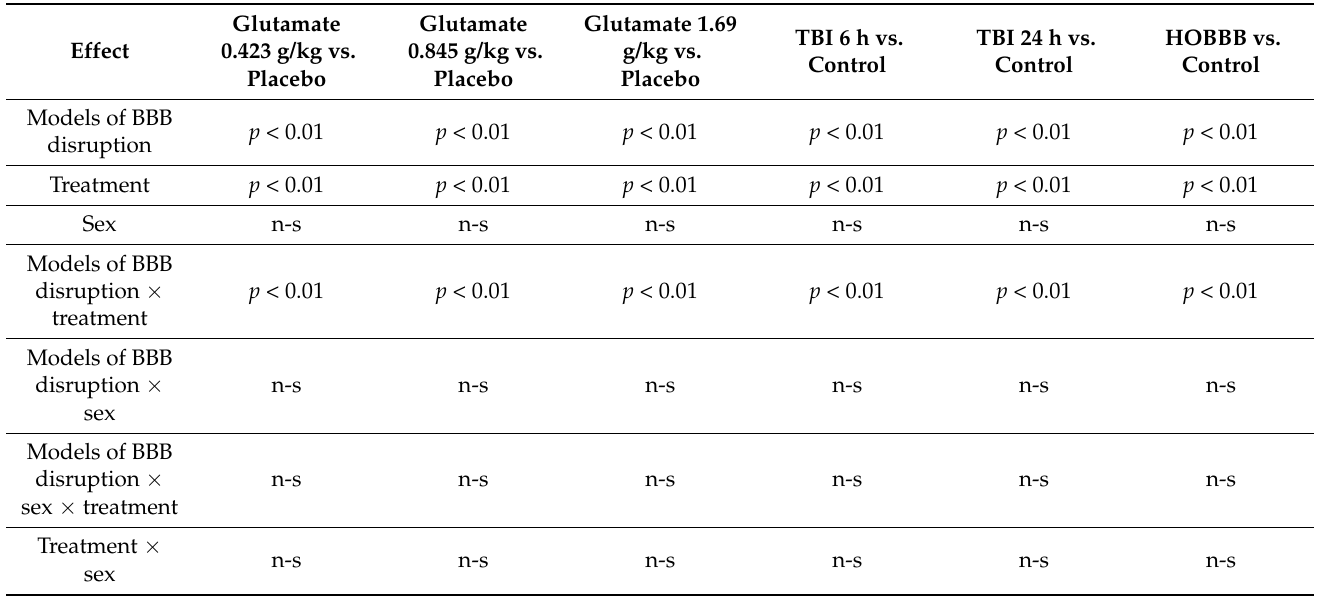
Table 3. Main effects of the model of BBB disruption, treatment and sex and their interaction effects on CSF glutamate level. No significance